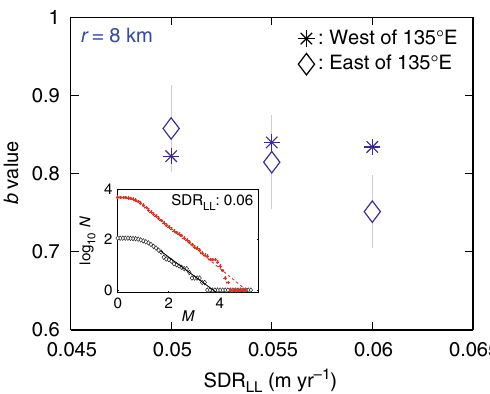
Fig. 3 b values for several values of SDR LL . Vertical bars in gray indicate bootstrapping errors displaying one standard deviation of bootstrap uncertainty. We used samples of a radius of r = 8 km. Asterisks mark the result for the region west of 135°E, and diamonds for the region east of 135° E. Inset: frequency – magnitude distribution for SDR LL = 0.06 m year −